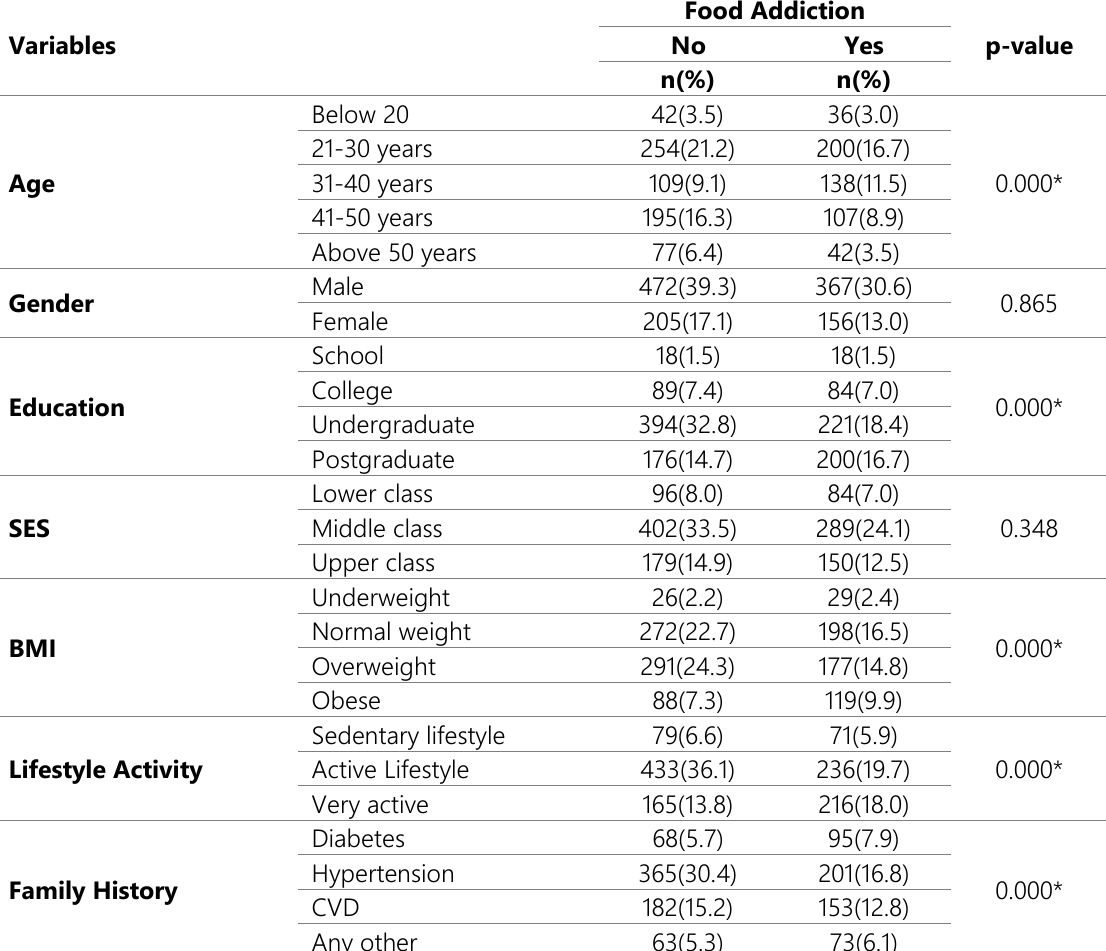
Table 5: Association of Food addiction with the demographic variables of the participants.